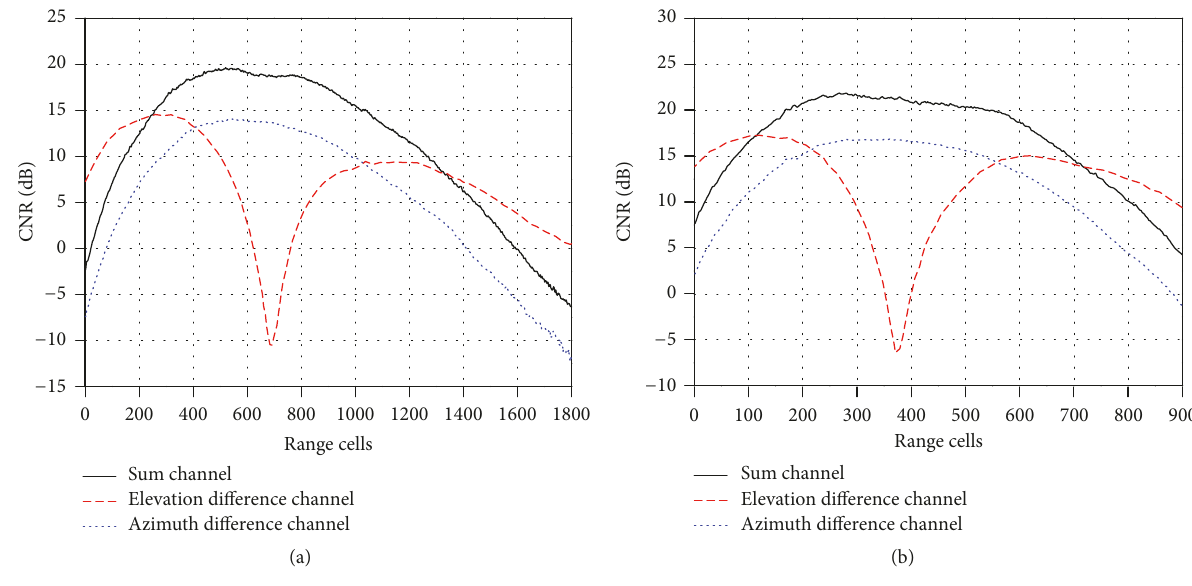
Figure 3: CNRs of the experimental sea clutter datasets: (a) DS1. (b)